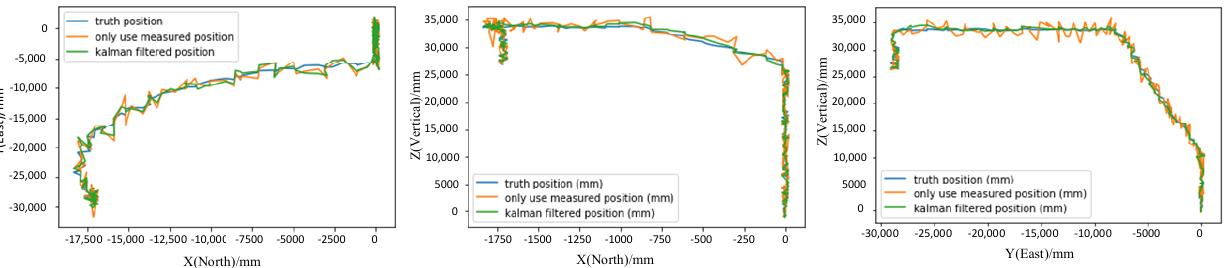
Figure 14. Hoisting route monitoring and comparison.